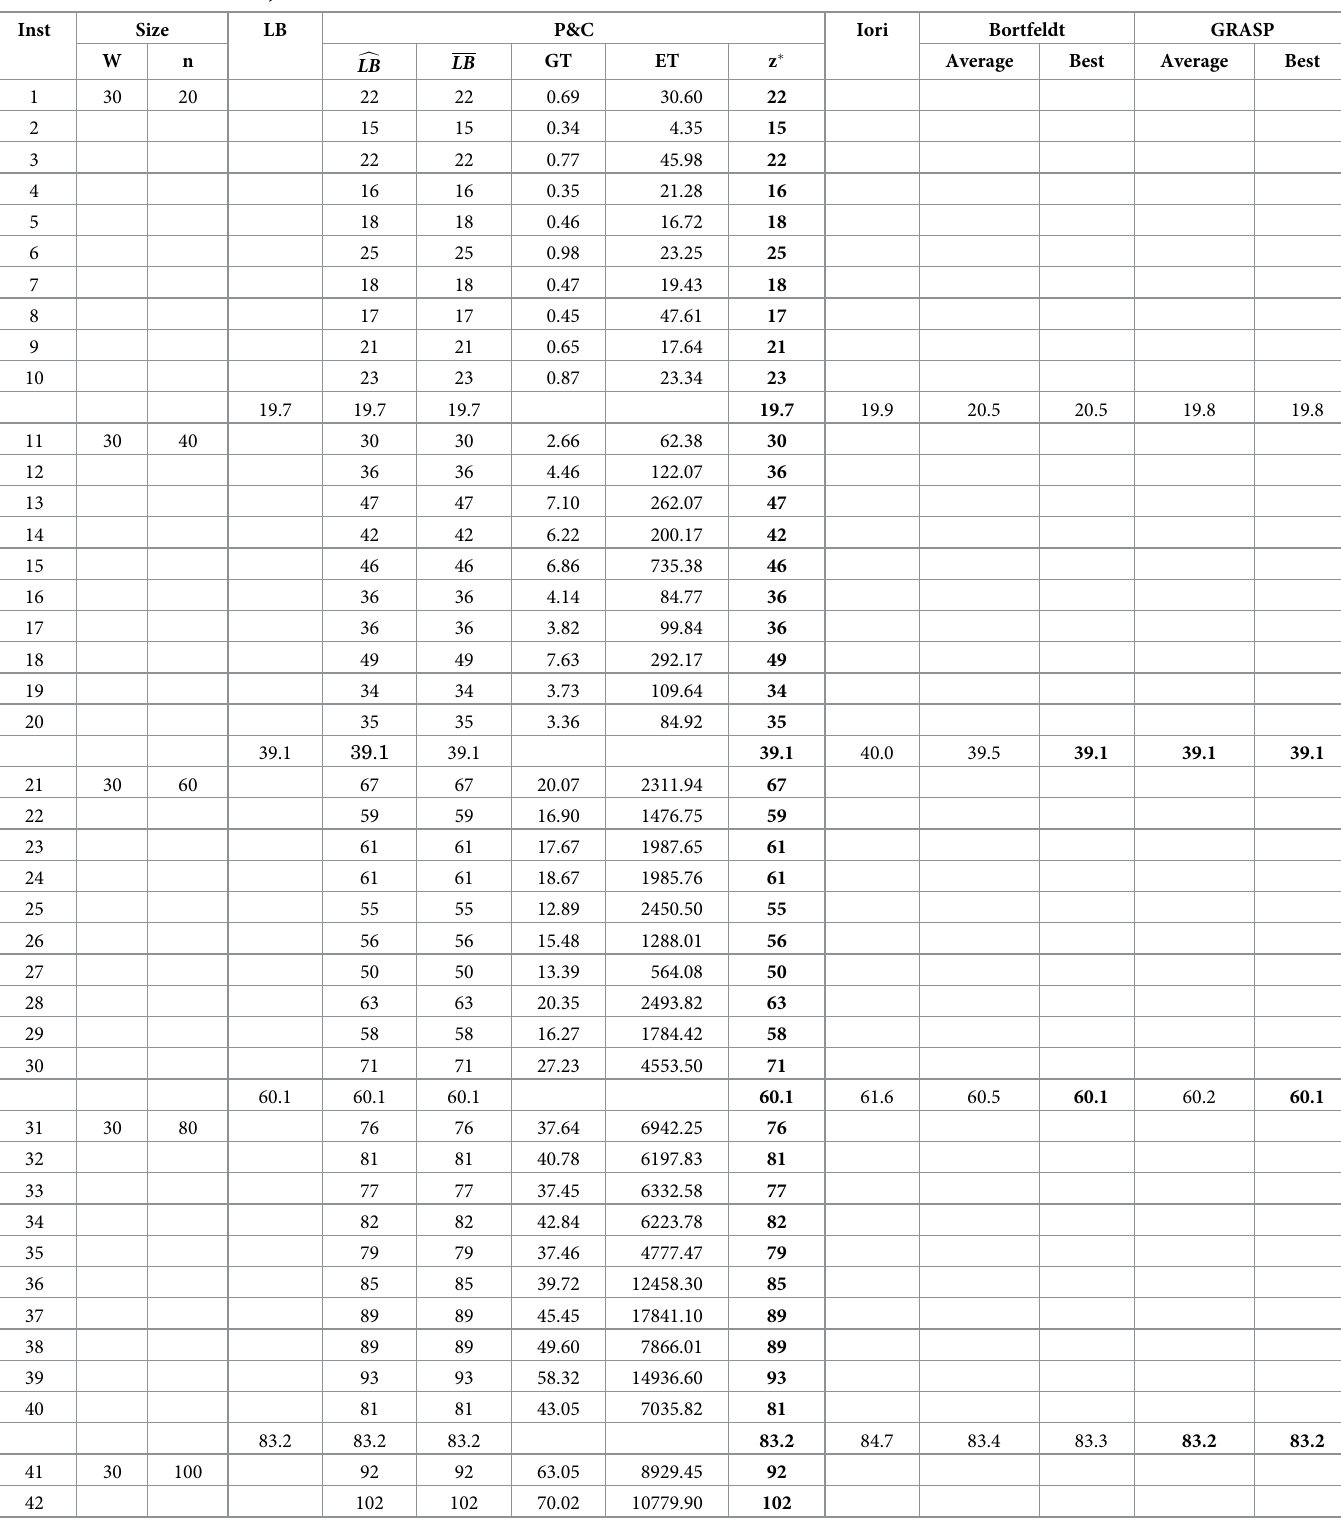
Table 9. Results for BW instances, class